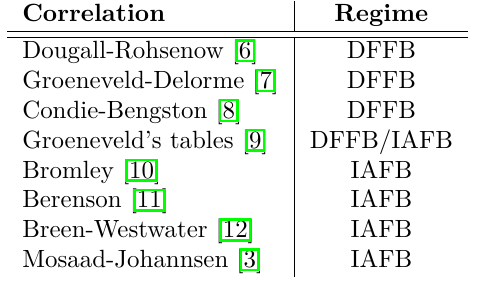
Table 1. Compared post critical correlations in TUBE 2.0.